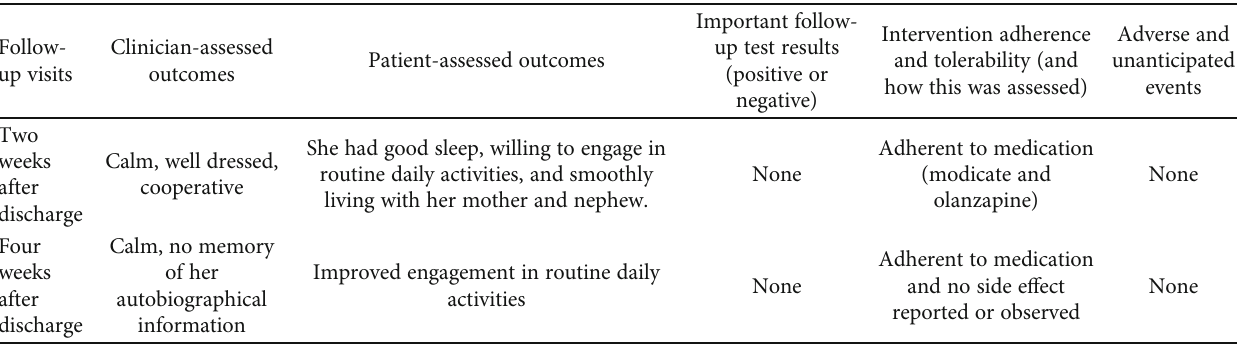
Table 2: Patient ’ s progress at